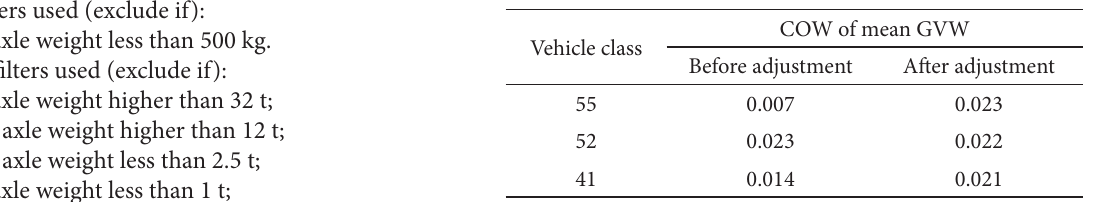
Table 2. Coefficient of variation of mean GVW before and after the adjustment – A3